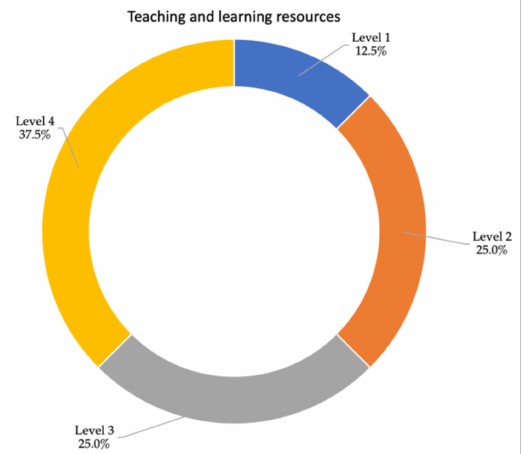
Figure 3. Teaching and learning resources by